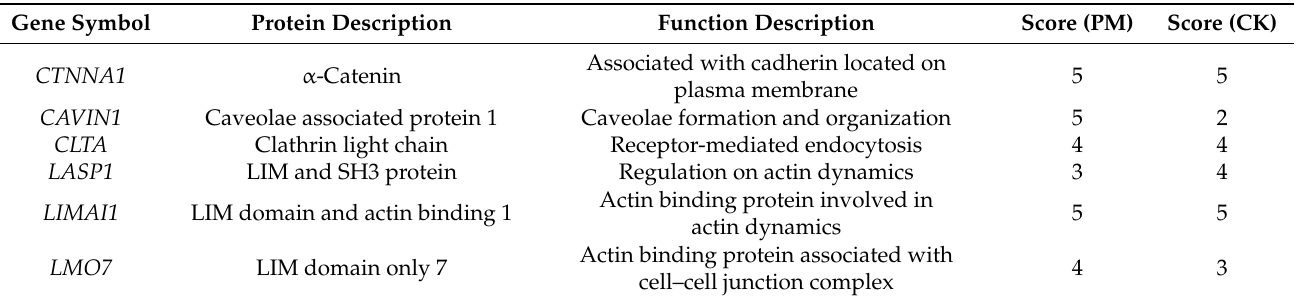
Table 1. Proteins associated with plasma membrane in the NRK-52E secretome exposed to 620